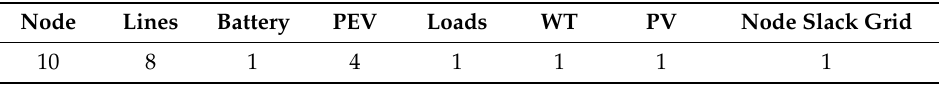
Table A1. Number of nodes and the microgrid components.